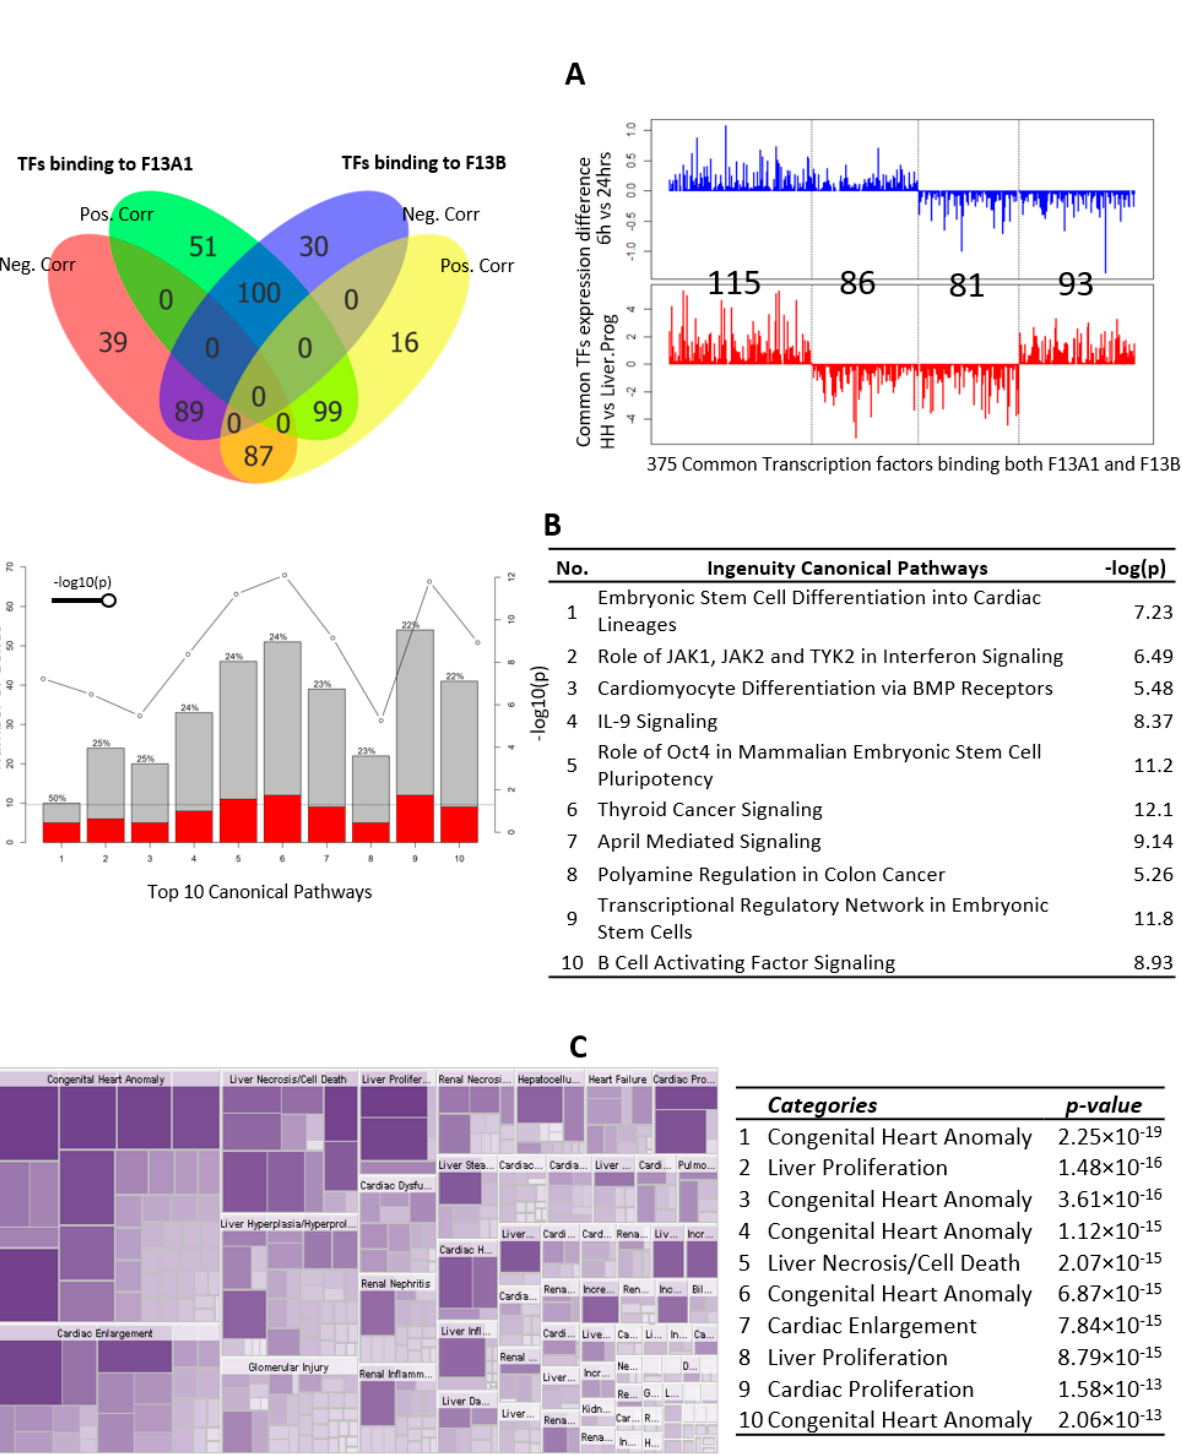
Figure 4. The common transcription regulation of F13A1 and F13B. ( A ) Left: the Venn Diagram of the positive and negative correlation of TFs binding to F13A1 and F13B, in macrophages 6 h vs. 24 h and liver progenitors cells vs. hepatocytes respectively. Right: the transcription factors expression difference in macrophage 6 h vs. 24 h and liver progenitor vs. hepatocytes for common transcription factors binding to both F13A1 and F13B. ( B ) The top 10 canonical pathways of common transcription factors binding to both F13A1 and F13B; red: the overlap transcription factor from our analysis; and grey: the total number of molecules in the pathway. ( C ) Left: the heatmap of all tox functions enriched with common transcription factors binding to both F13A1 and F13B; right: the Top 10 Tox functions of the common transcription factor binding to both F13A1 and F13B.